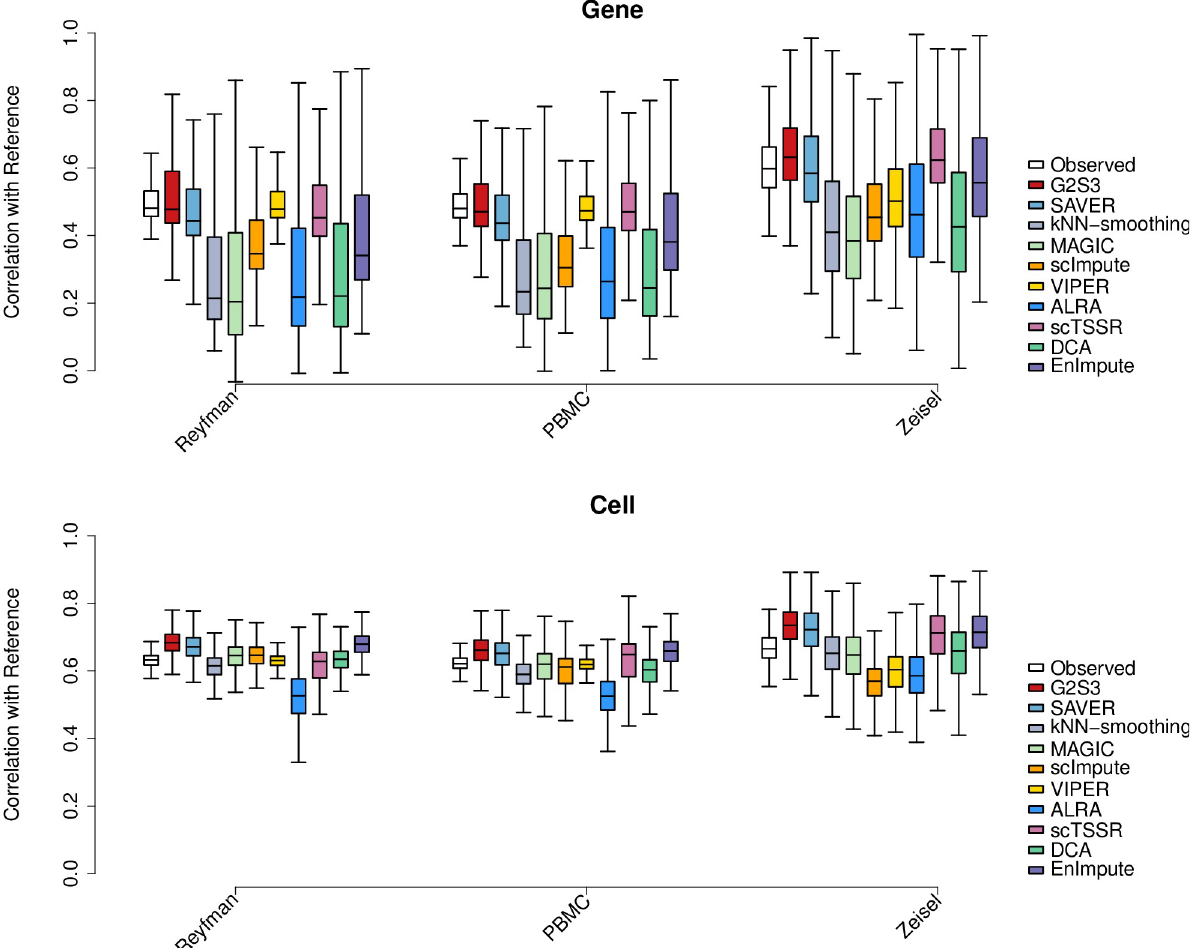
Fig 1. Evaluation of expression data recovery of G2S3 by down-sampling. Performance of imputation methods measured by correlation with reference data from the first category of datasets, using gene-wise (top) and cell-wise (bottom) correlation. Box plots show the median (center line), interquartile range (hinges), and 1.5 times the interquartile (whiskers).